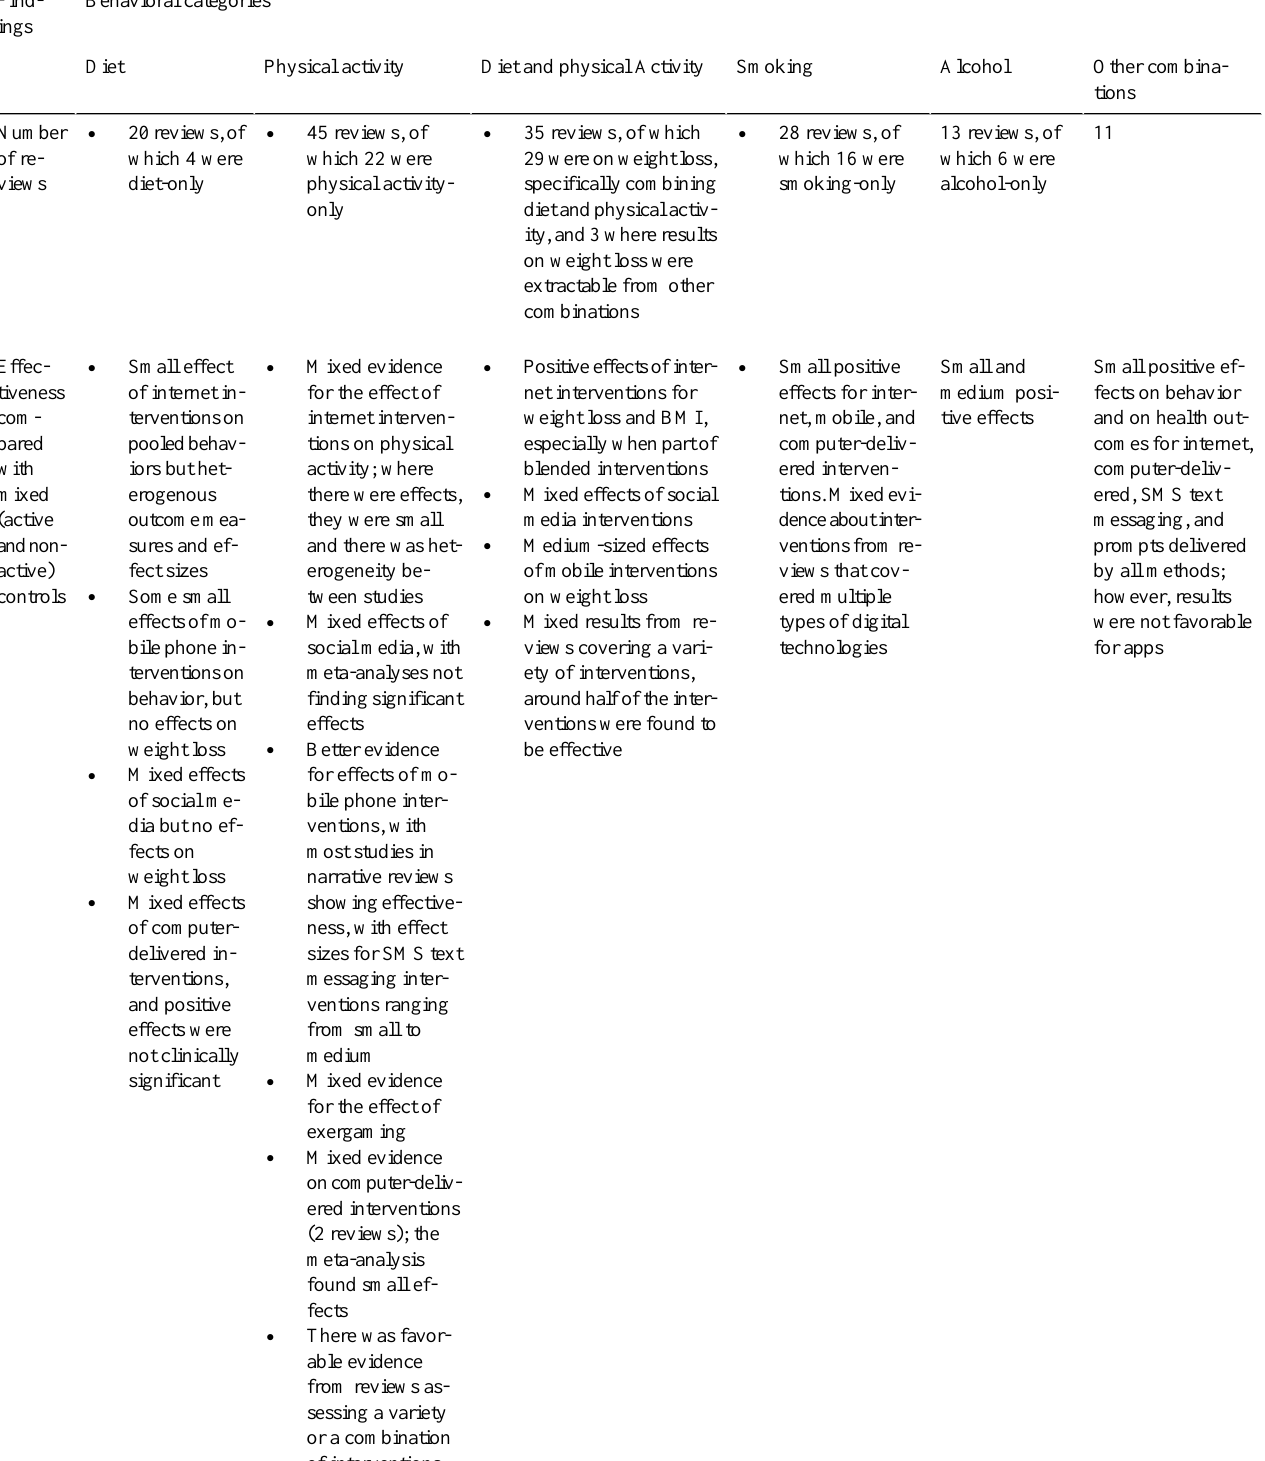
Table 2. Summary of the effectiveness of different types of interventions. Behavioral categoriesFind-